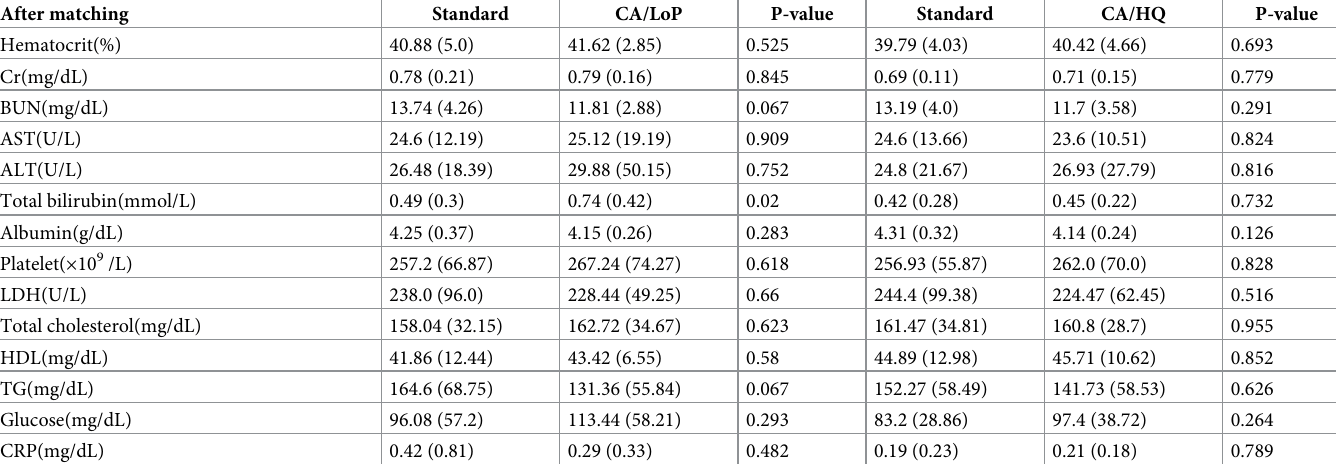
show significant difference between standard group and CA/HQ (Table 3) . Between CA/LoP and CA/HQ, no endpoints showed significant difference. Only viral clearance duration was shorter in CA/HQ than CA/LoP, but it was not significant as well (Table 3) . After matching, none of the endpoints were significantly different between standard group and treatment groups (Table 3) . Also, between CA/HQ and CA/LoP, there was no significant difference in all endpoints (S2 Table) . Table 3. Clinical outcomes before and after propensity score matching.